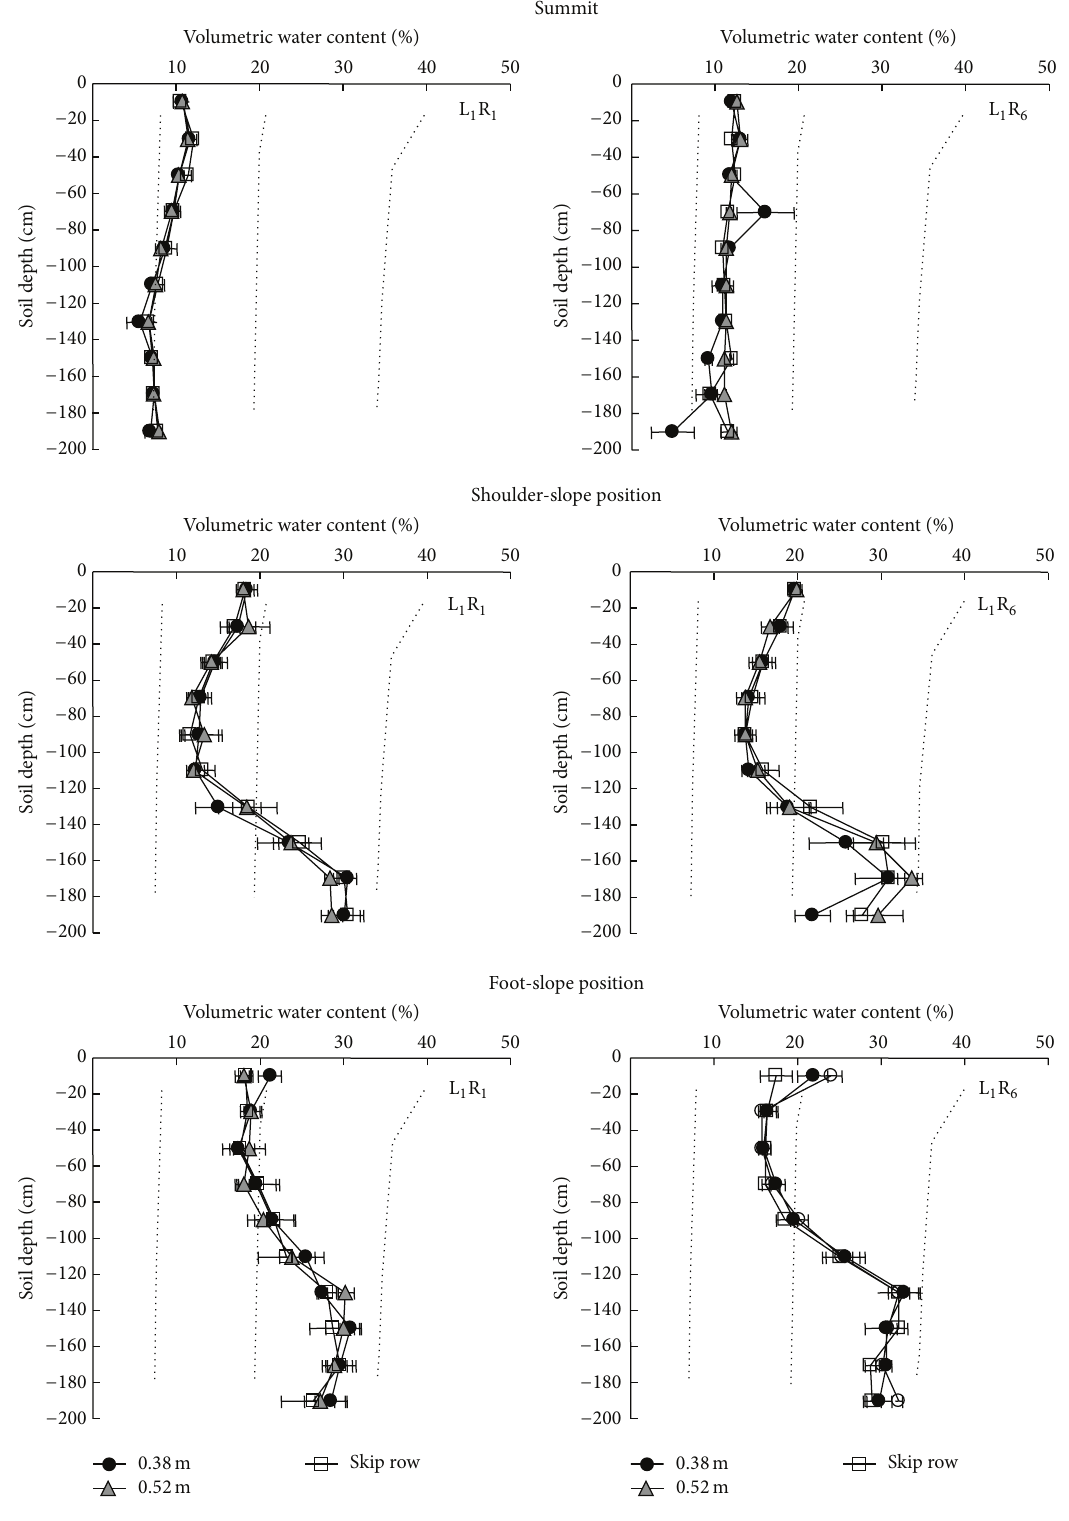
Figure 1: Volumetric water contents of soil profiles (0–200 cm depth) at silking (R 1 ) and physiological maturity (R 6 ) of maize crops cultivated at three landscape positions (summit, shoulder-slope position, and foot-slope position) and three row spacings (0.38 m, 0.52 m, and 0.38 m in a 2 × 1 skip-row pattern) during 2006/07 (location 1; L 1 ). Values are the mean ± standard error of three replicates. Dotted lines indicate volumetric water contents at lower limit, upper limit, and saturation determined in